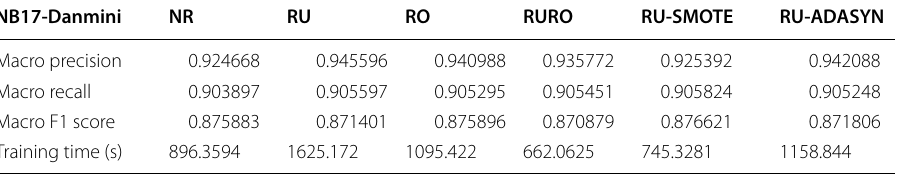
Table 42 ANN classification results for NB17-Danmini on local machine for